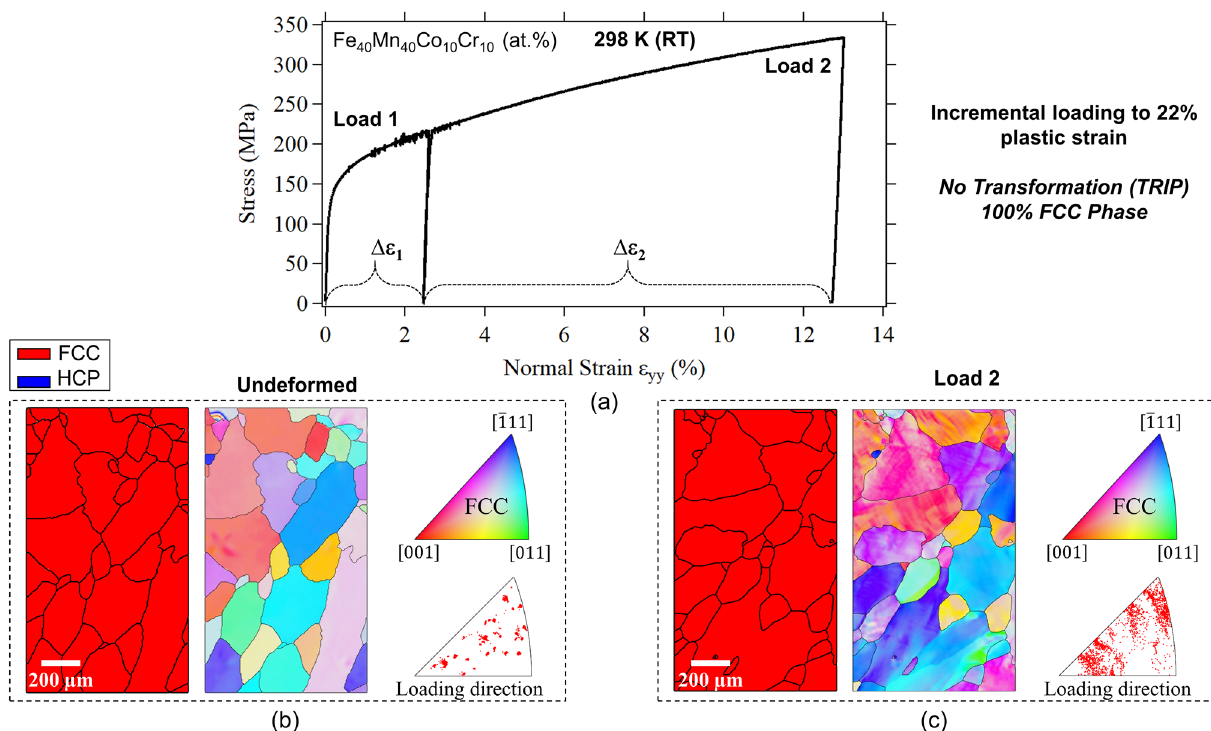
Figure 2. ( a ) Stress–strain curves following incremental loading at room-temperature (RT). ( b ) Phase map and grain orientation map obtained from the gauge section of the specimen before deformation. ( c ) Phase and grain orientation maps collected from the same area shown in ( b ) following the shown loading history (about 13% strain). Undeformed and deformed conditions point to FCC single phase with no signs of phase